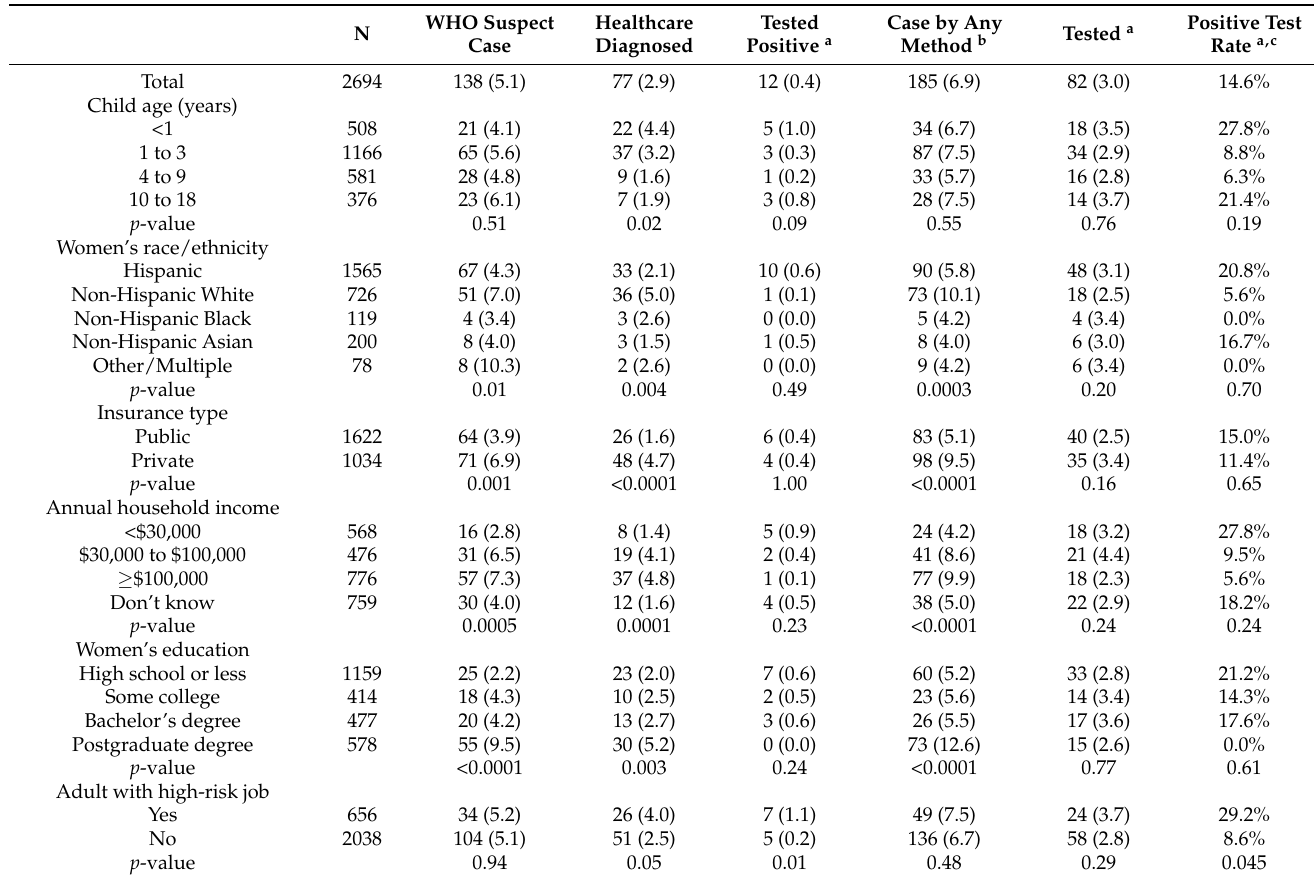
Table 1. Prevalence of COVID-19 cases and testing among children age ≤ 18 years according to sociodemographic factors, NYU CHES, 20 April–31 August 2020.